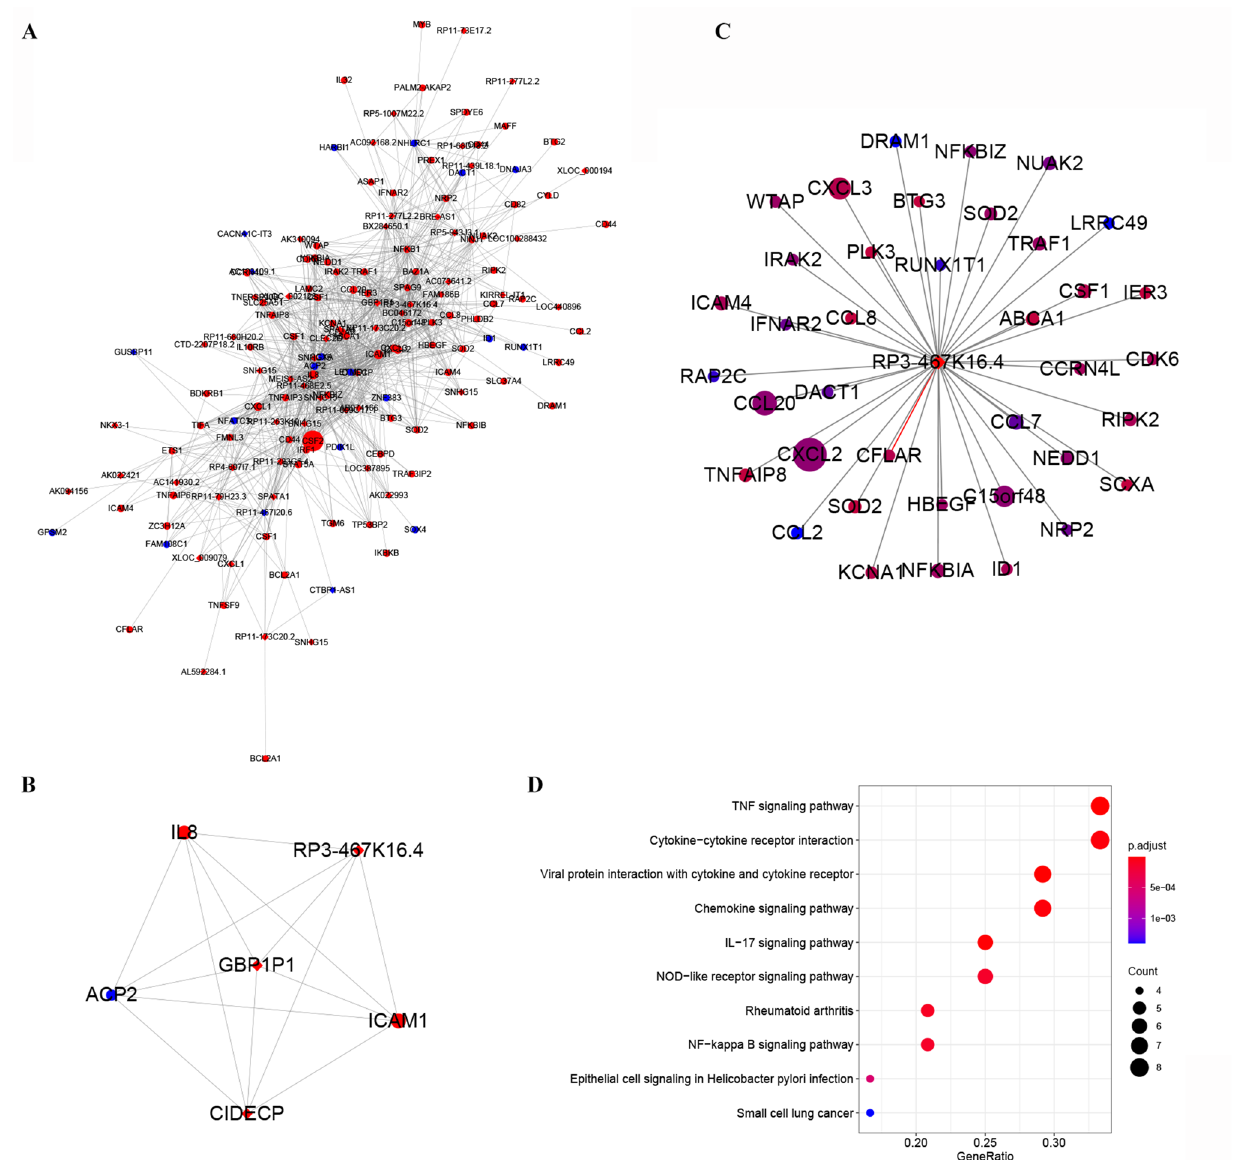
Figure 6. Co-expression networks of mRNAs and lncRNAs in SFMSCs after IL-1β treatment for 2 h constructed by weighted correlation network analysis. ( A ) Correlation network constructed using the mRNAs and lncRNAs in the most significant modules in Fig. 5A (MEgreen, top 1000 weight value). ( B ) Top K-score subnetwork. ( C ) mRNAs co-expressed with the top K-score lncRNA RP3-467K16.4 . Weighted correlation network analysis of Pearson’s correlations was used to estimate associations between the lncRNA and mRNAs. ( D ) KEGG pathway enrichment analysis of the mRNAs co-expressed with RP3-467K16.4 , with the top 10 enriched genes/ratios. Genes/ratios: number of differently expressed genes enriched in the pathway/number of all differently expressed genes associated with RP3-467K16.4. Circles, mRNAs; diamonds, lncRNAs. Different sizes represent the absolute value of the fold change. Red, upregulated; blue, downregulated. Seqname was used to label the genes. Images ( A – C ) were created using Cytoscape 3.8.0, Software. Image ( D ) was performed using R Software created by R Core Team (2020). R: A language and environment for statistical computing. R Foundation for Statistical Computing, Vienna, Austria. https:// www.R- proje ct. inflammatory factor secretion, creating a “positive inflammatory loop” that results in destruction progression 33,34 . The cartilage damage caused by the inflammatory immune response requires MSCs to spontaneously differenti- ate into chondrocytes for repair 35 . Meanwhile, the upregulated IL-1β enhances IL-1Ra secretion of MSCs, which blocks the “positive inflammatory loop” in an IL-1Ra-dependent manner, and induces macrophage polarization toward the M2 phenotype 34–37 . This is the theoretical basis of stem cell-based therapy for arthritis. In this study, we explored the effects of IL-1β on lncRNA and mRNA expression profiles of human SFMSCs, which may help us understand in more detail the regulation mechanism underlying this biological process.